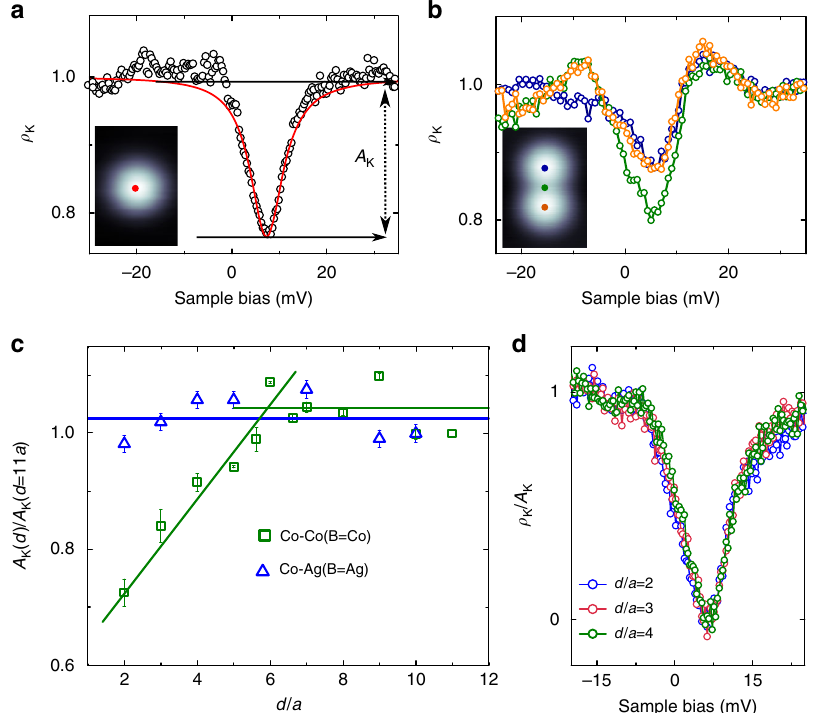
Fig. 2 Kondo resonance of individual Co atoms and dimers on Ag(111). a d I /d V at the atom centre (circles), and fi t to Eq. (1) yielding Γ 0 = 8.6 ± 0.6 meV, q = 0.02 ± 0.02 and ϵ ¼ 7 : 1 ± 0 : 2 meV (red line). b d I /d V over Co atoms (blue and orange open circles) in a dimer at d = 2 a ( a = 2.89 Å is the Ag(111) 0 surface lattice parameter) and over the midpoint between them (green circles). Insets display the corresponding constant current topographic images (width 1.3 nm) and the dots mark the position where spectroscopy was taken. c A K (de fi ned in panel a ) variation of a Co atom as another Co (squares) or Ag (triangles) atom is approached. Data are extracted from fi ts to individual spectra acquired over the atoms, and the amplitude is normalized by its corresponding value with the second atom at a distance of d = 11 a from the fi xed Co (See Supplementary Note 2). Error bars are standard deviations obtained during the fi tting procedure. d d I /d V normalized by A K showing that the shape of the ZBF does not change as Co atoms are approached (i.e., Γ 0 , q and ϵ 0 remain constant). In panels a , c , and d , the set point is the general value given in Methods, in panel b the set point is − 20 mV and 15 pA, with